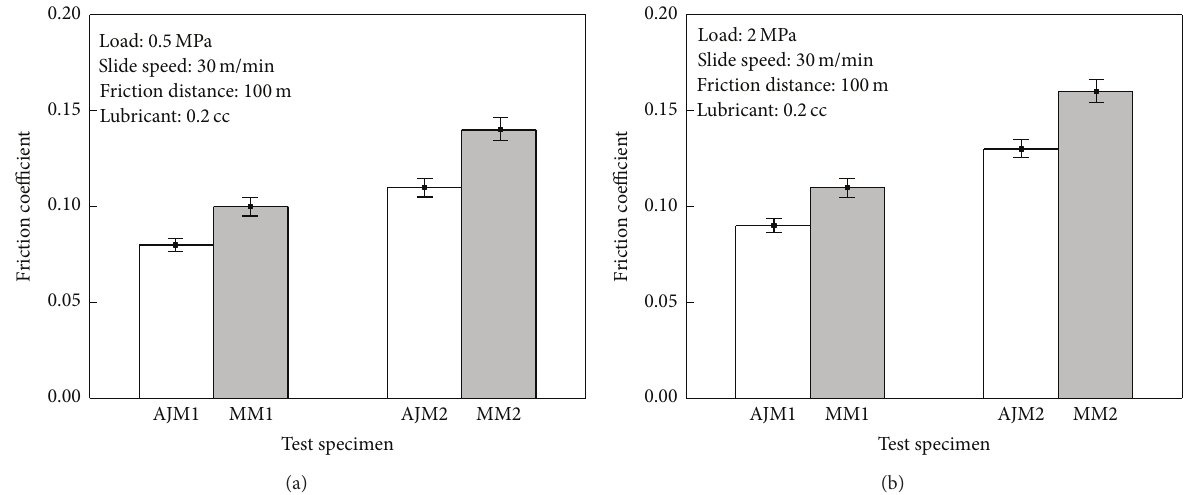
Figure 3: Relationship between the shapes of machined surfaces and friction coefficients under the load of (a) 0.5 MPa, (b) 2 MPa.